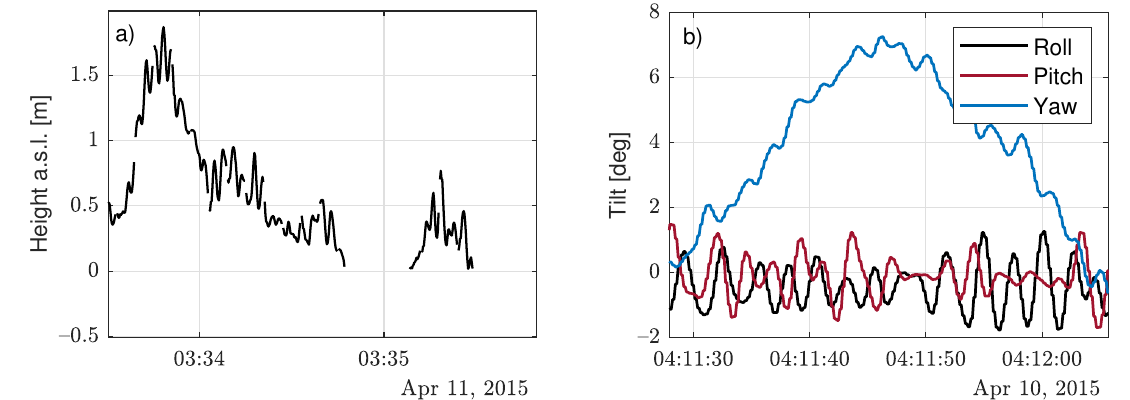
Figure 4. Motional temporal series (Ijmuiden campaign): ( a ) heave signal above sea level (a.s.l.) on 11 April 2015 and ( b ) roll, pitch, and yaw signals on 10 April